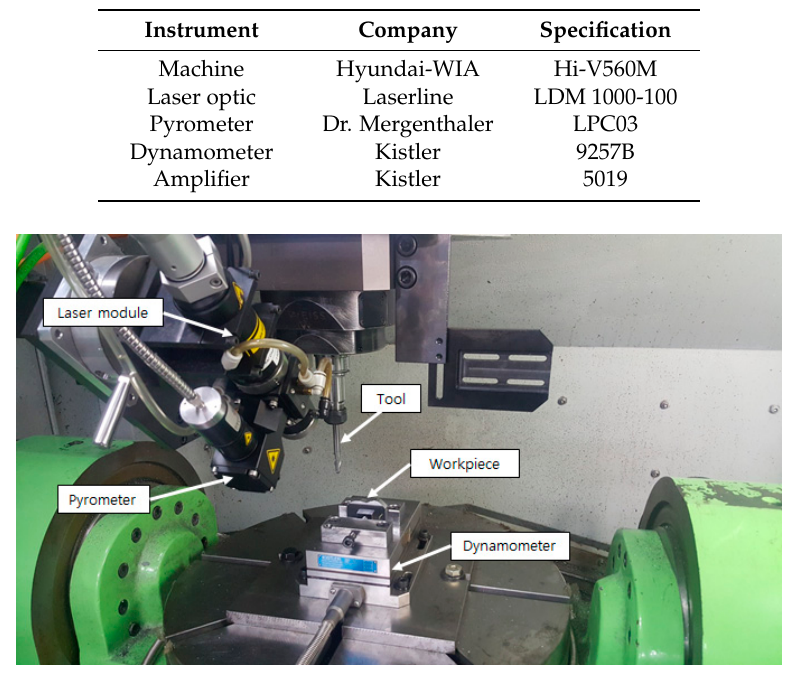
Figure 12. Changes of laser heat source shape according to curved surface.